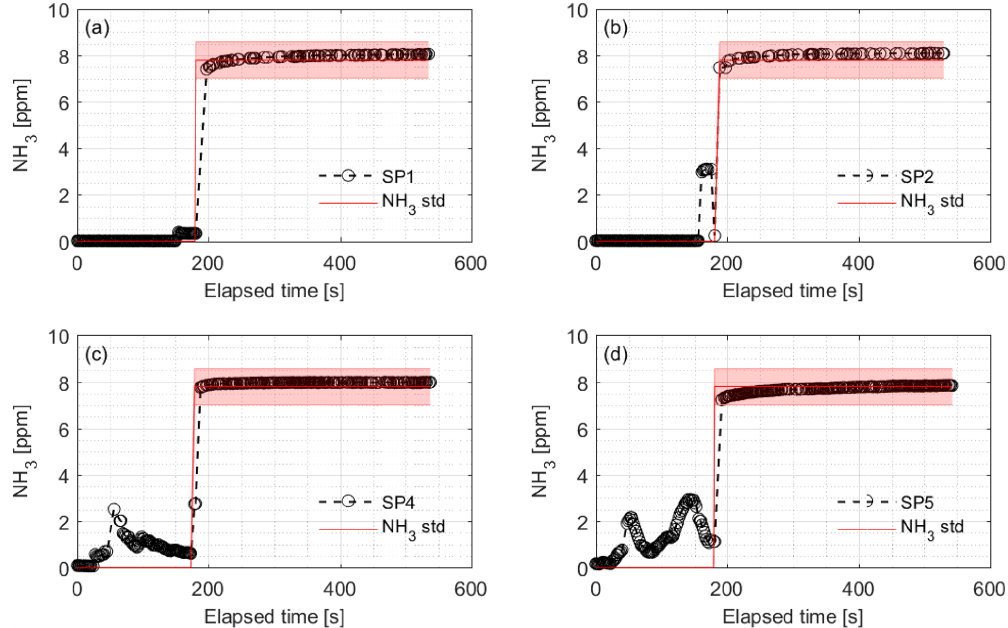
Figure 9. Calibration of the NH 3 sampling and measurement system and associated response times of the CRDS during field testing. Introduction of 7.8ppm NH 3 gas was at (a) SP1, (b) SP2, (c) SP4 and (d) SP5 while monitoring the NH 3 concentration at the outlet port connected to the analyzer. SP denotes sampling point. The rise times were 7.3, 3.0, 8.4 and 5.9s for SP1, SP2, SP4 and SP5, respectively. The red line and area represent the NH 3 standard concentration with